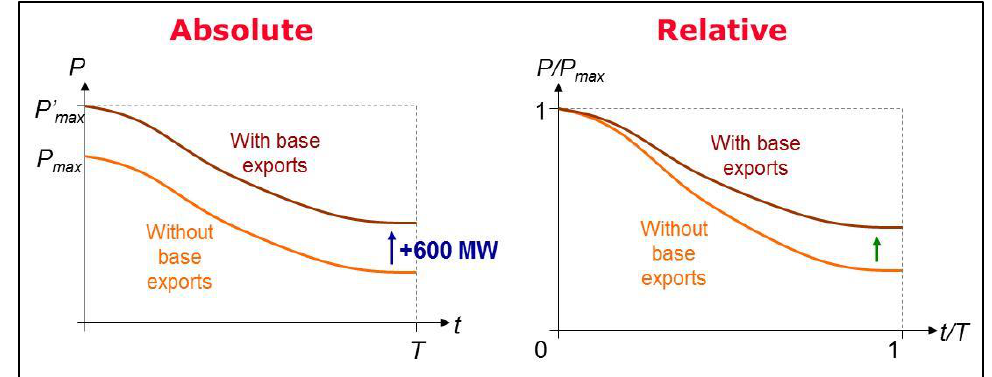
Figure 3. Modifying absolute and relative load duration curve (LDC) in order to accommodate for base power exports.